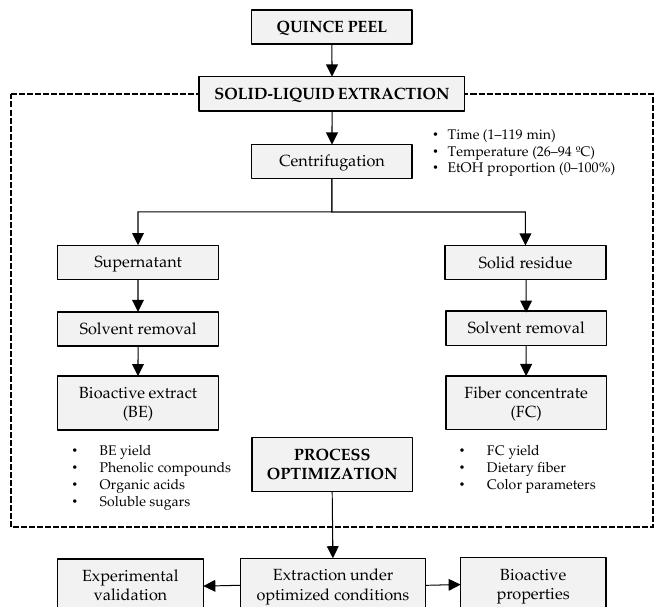
Figure 1. Flowchart of the steps involved in the preparation of bioactive extracts (BE) and fiber concentrates (FC) from quince peel and experimental responses considered for process